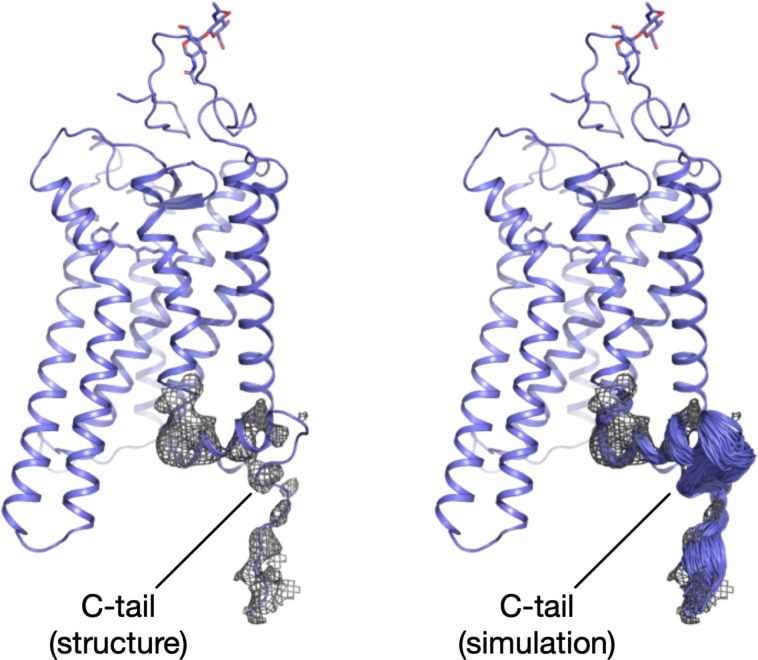
Flexible fitting of the C-tail in the electron density.Structural model of rhodopsin displaying the electron density at a 10σ cuf-off around H8 and the C-tail (left), and snapshots of this region during the MDFF simulation (right).